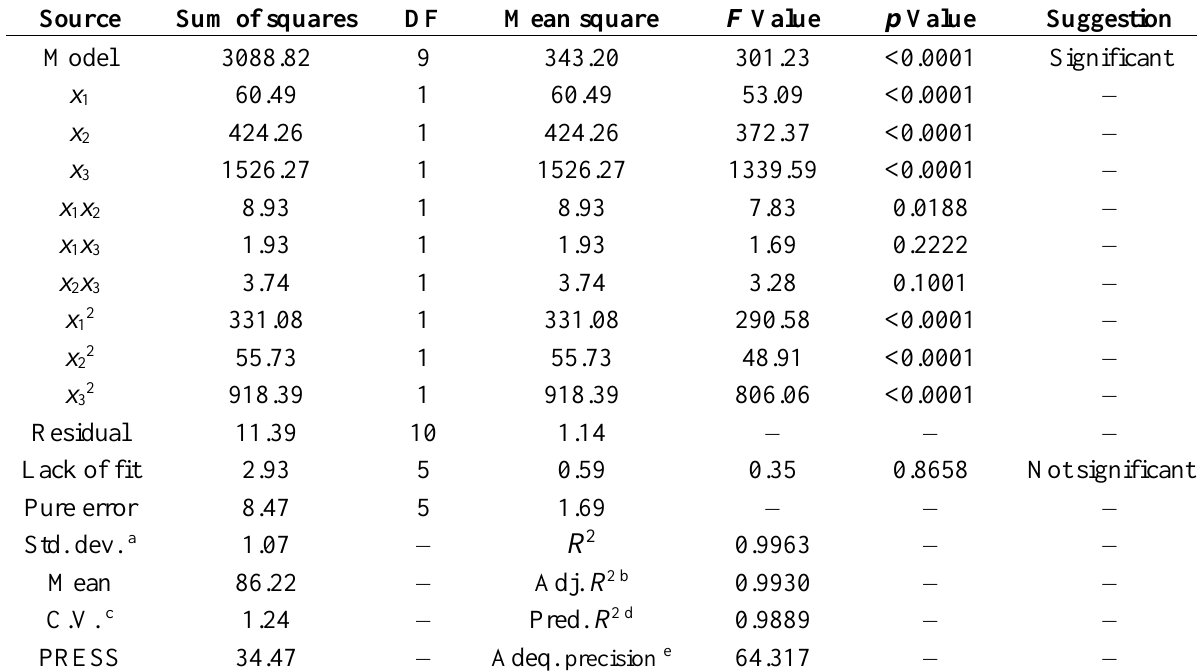
Table 4. ANOVA for the response surface quadratic